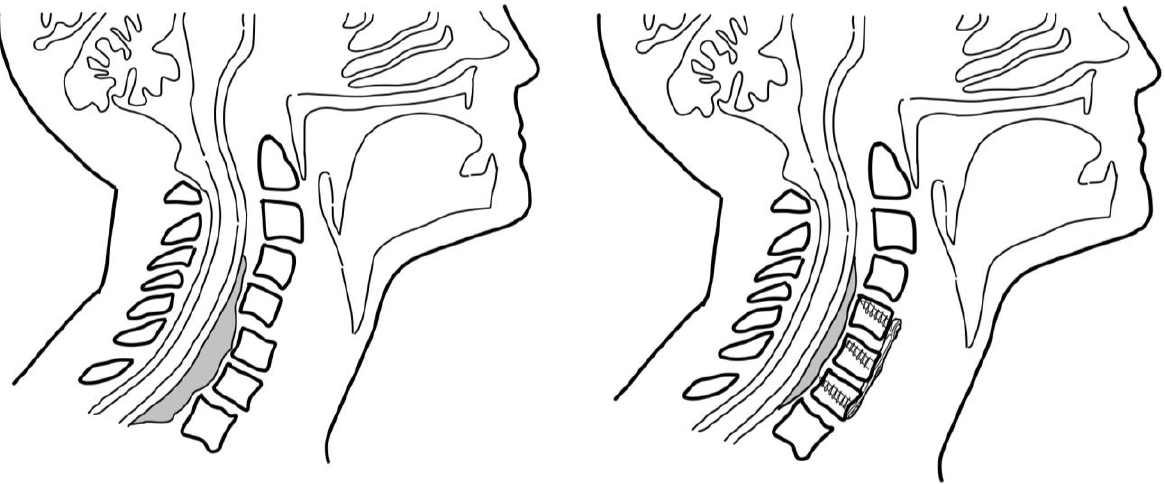
Figure 5. Depiction of pre and post-intervention anterior cervical fusion for extradural vertebral